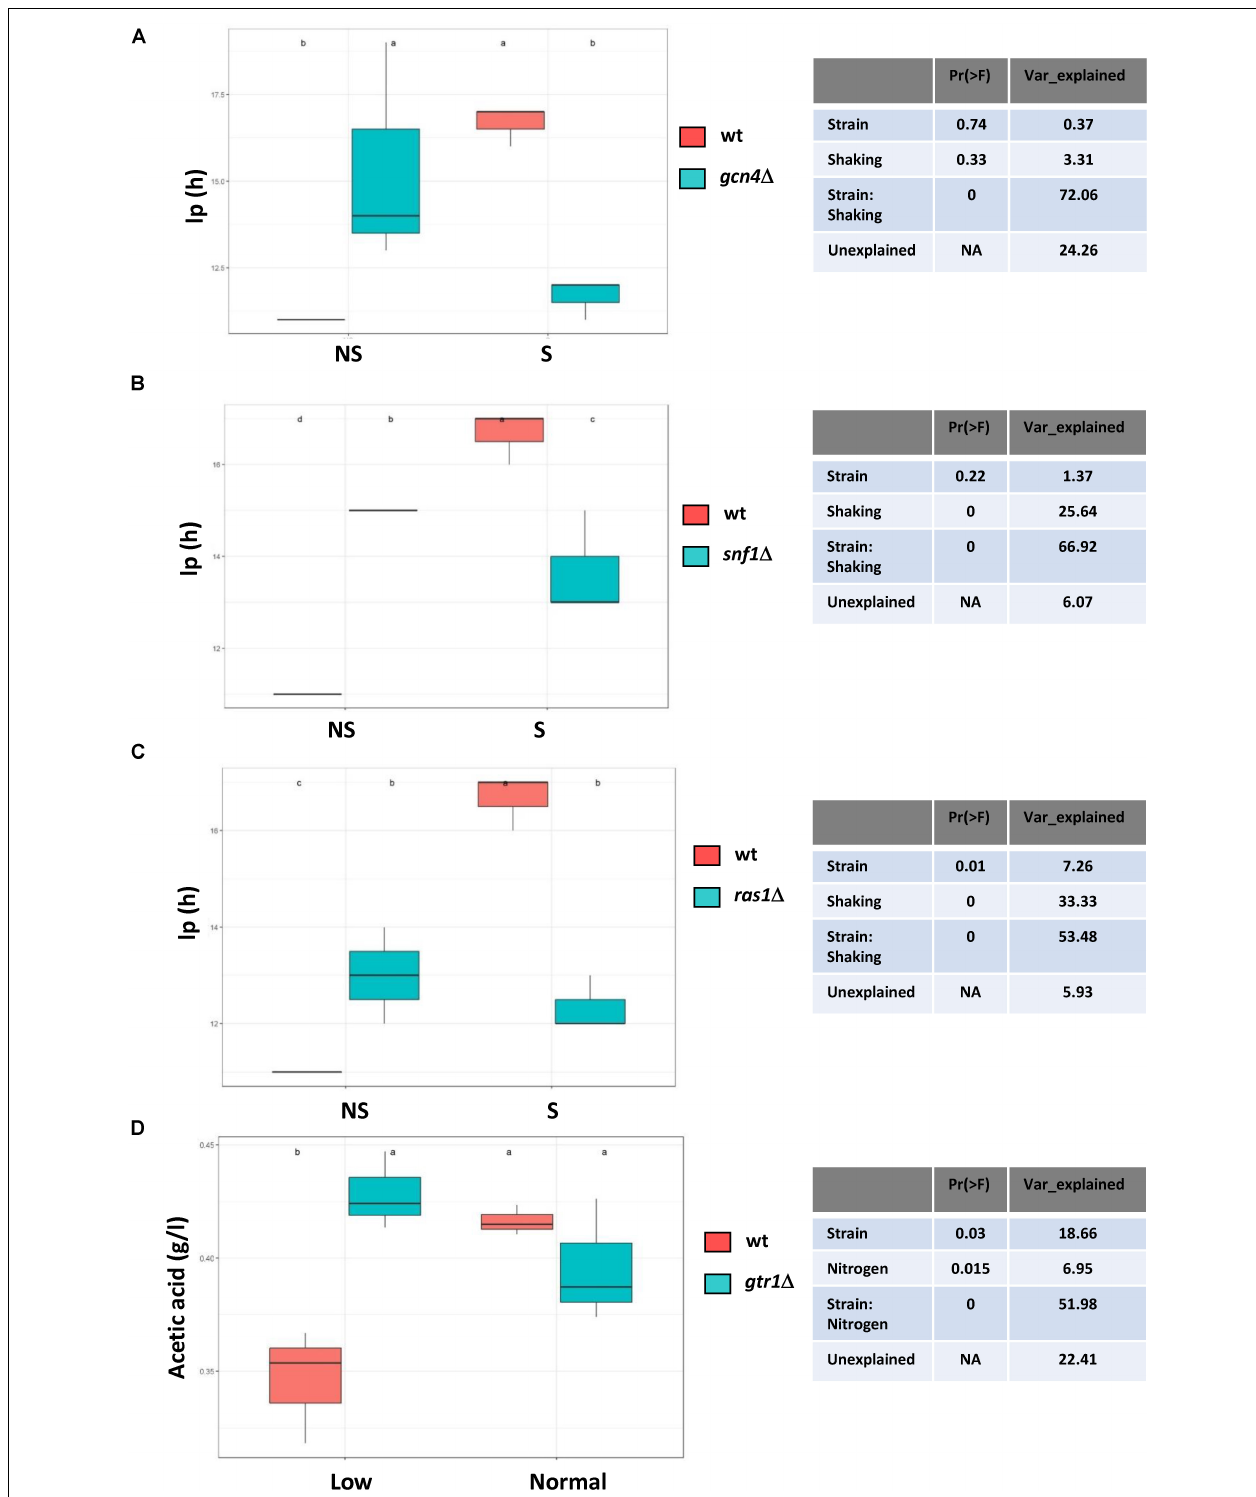
FIGURE 5 | Genome-environment interaction effect on some parameters of enological interest. Four cases are shown for which variance was caused by the mutation: the environment interaction was over 50%. (A) lag phase time without and with shaking in mutant gcn4 (cid:49) . (B) lag phase time without and with shaking in mutant snf1 (cid:49) . (C) lag phase time without and with shaking in mutant ras1 (cid:49) . (D) Acetic acid production with low and normal nitrogen in mutant gtr1 (cid:49) . The shown values are the means of three replicates. Error bars represent standard error. Statistically different parameters are indicated by a different letter.